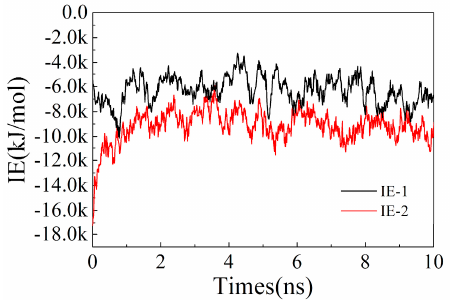
Figure 11. Change of interaction between sodium ions and ion exchange resins. IE − 1 represents the